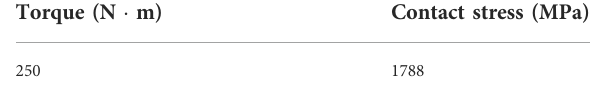
TABLE 4 Numerical simulation